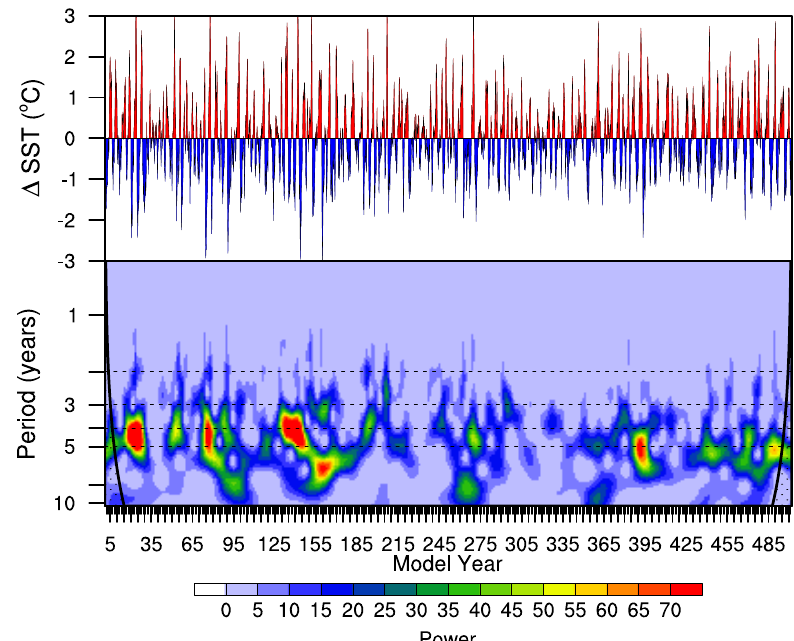
Fig. 9. The Ni˜no3.4 index ( ◦ C) from the mPWP simulation (top) and the corresponding wavelet power spectrum (bottom).